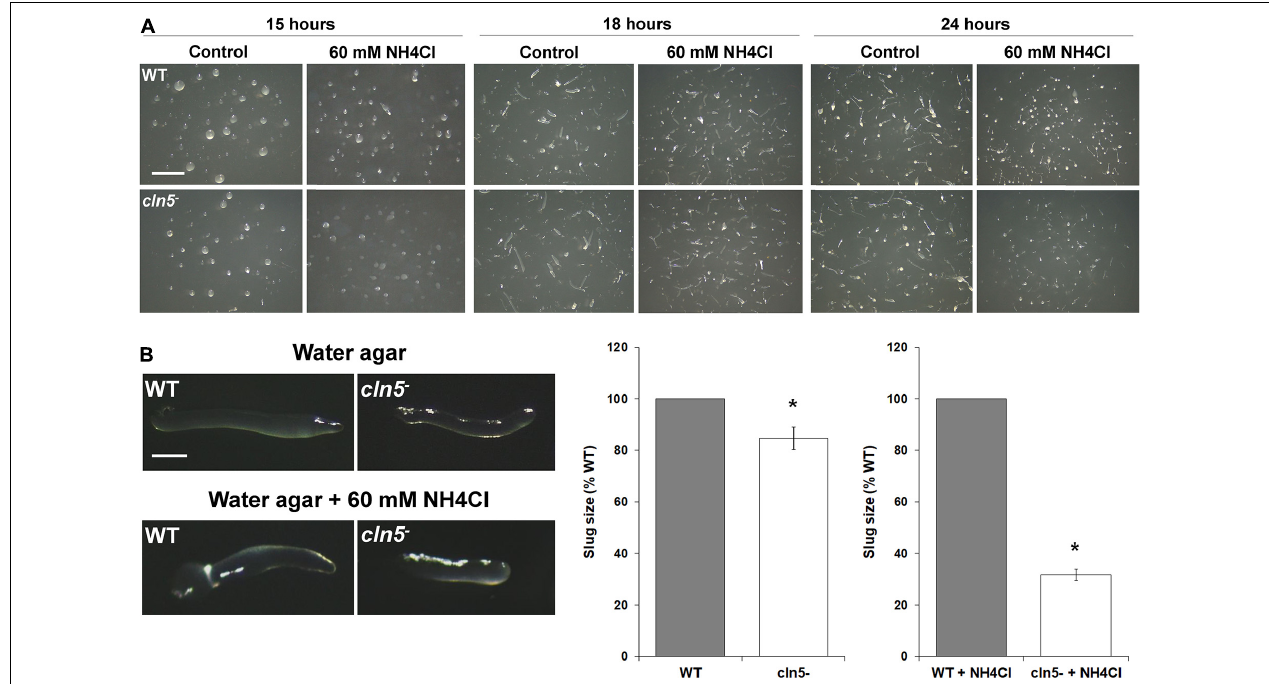
FIGURE 10 | Effect of cln5 -deficiency on multicellular development when autophagy is inhibited. (A) WT and cln5 − cells were deposited on 0.5% agar/distilled water ± ammonium chloride (60 mM). Images were taken at the mound/tipped mound (15 h), finger/slug (18 h), and fruiting body (24 h) stages of development. Images are representative of three independent experiments. Scale bar = 2.5 mm. (B) Effect of cln5 -deficiency on slug size ± ammonium chloride (60 mM). Scale bar = 50 µ m. Raw values were then expressed as a percentage of WT slug size. Data presented as mean slug size (% WT) ± SEM ( n = 3, at least eight slugs were quantified for each biological replicate). Statistical significance was determined using the one-sample t -test. * p -value < 0.05 vs.